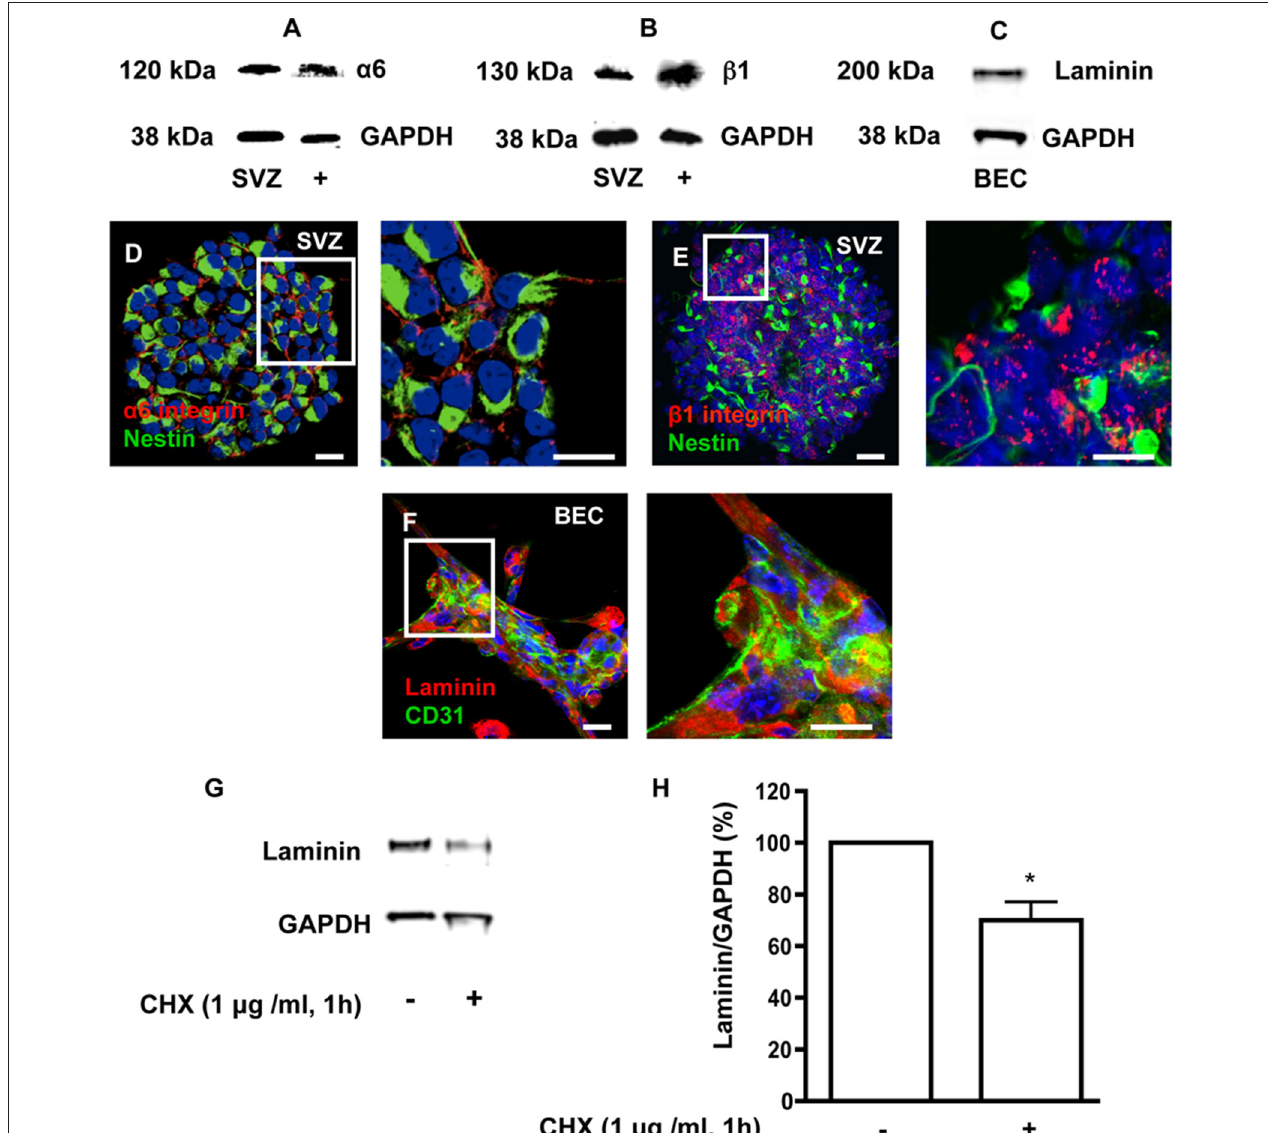
FIGURE 2 | SVZ cells express α 6 and β 1 integrins and BEC express laminin. (A,B) Detection of α 6 (A) and β 1 (B) integrin proteins by Western blotting in SVZ neurospheres and in whole brain extracts (positive control). (C) Detection of laminin by Western blotting in BEC. GAPDH protein detection was used as a loading control. (D,E) Representative confocal digital images depicting the presence of α 6 (D) and β 1 (E) integrin subunits in SVZ neurospheres (red staining for α 6 and β 1 integrins and green staining for Nestin, Hoechst 33342 nuclear staining in blue). Scale bars, 20 µ m. (F) Confocal digital image shows the expression of laminin in BEC (green staining for CD31, red staining for laminin, Hoechst 33342 nuclear staining in blue). Scale bars, 20 µ m. Cycloheximide (CHX) downregulates laminin in BEC. (G) Western blot showing laminin protein levels in untreated BEC cultures and in BEC treated with 1 µ g/ml CHX for 1 h. GAPDH protein detection was used as a loading control. (H) Bar graphs show the respective quantification of laminin levels. * P < 0.05, using the unpaired Student t -test for comparison with untreated